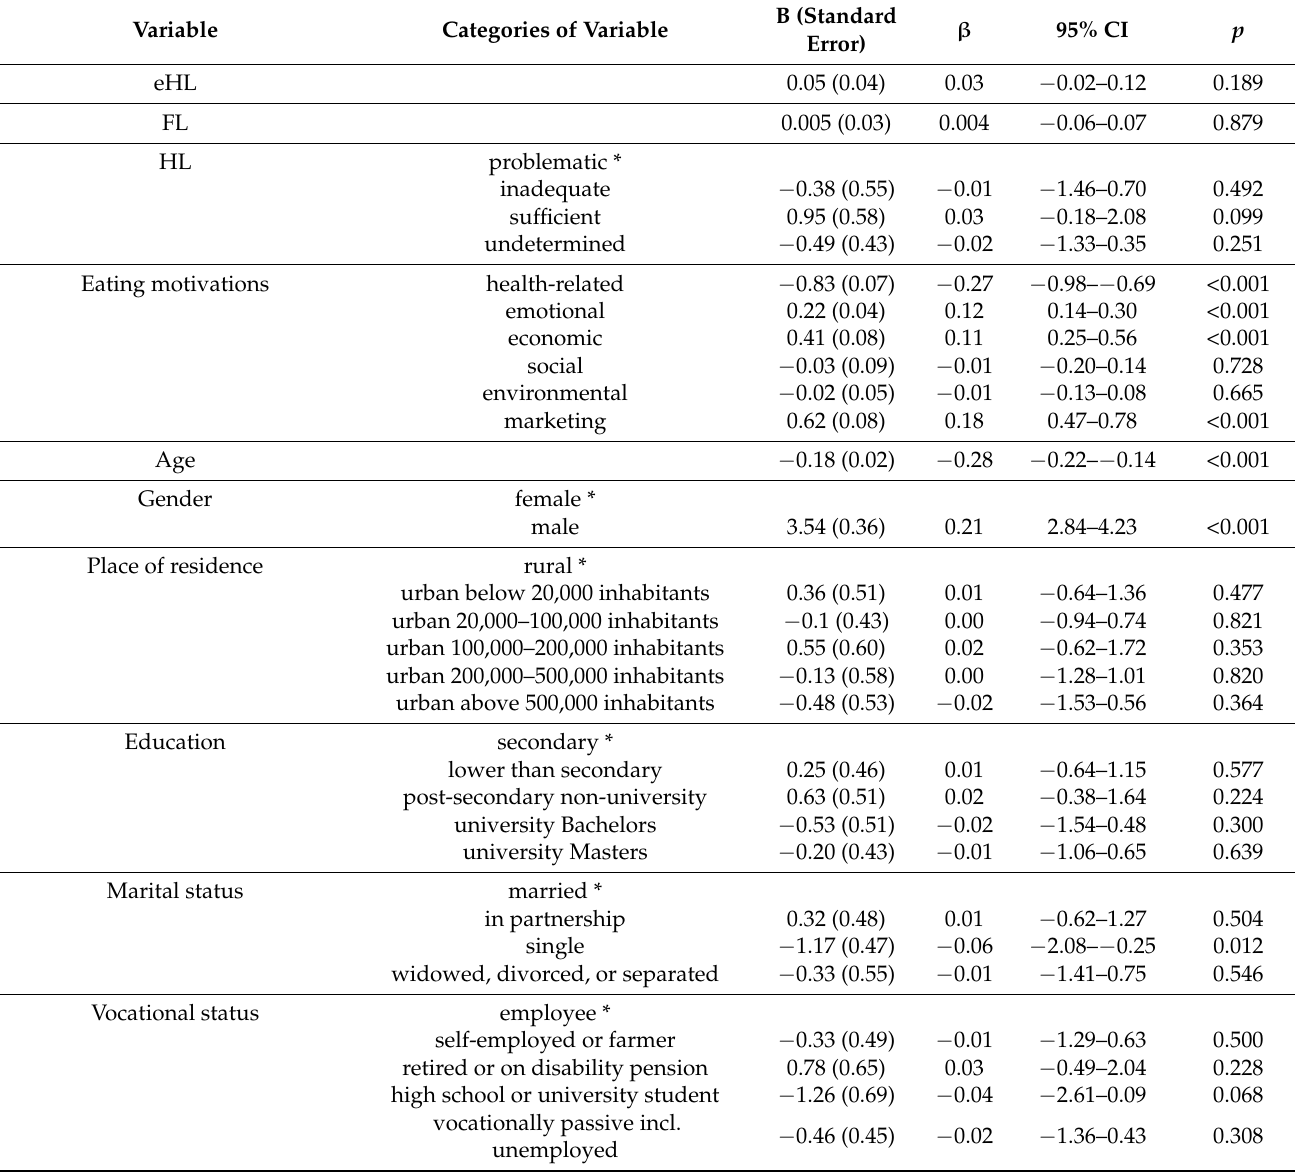
Table 4. Multiple linear regression of the Index of Unhealthy Food Choices as dependent variable (ANOVA, F = 18.584, p < 0.001, R2 =